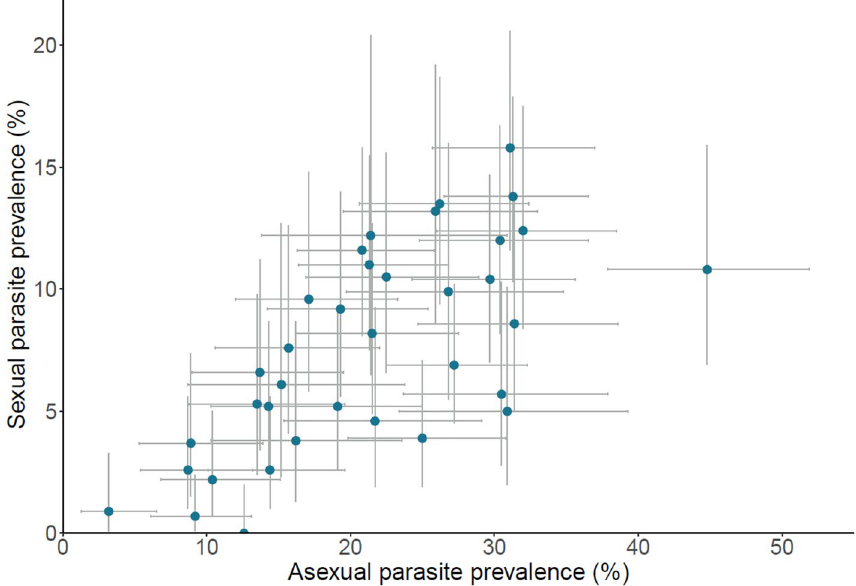
Figure 3. Significant positive correlation between asexual and sexual malaria parasite prevalence in children up to 5 years of age in each of the 36 states within Nigeria (Spearman’s rho = 0.70, P < 0.001). 95% CIs are shown for all estimates, and all values are shown in Supplementary Table S1.